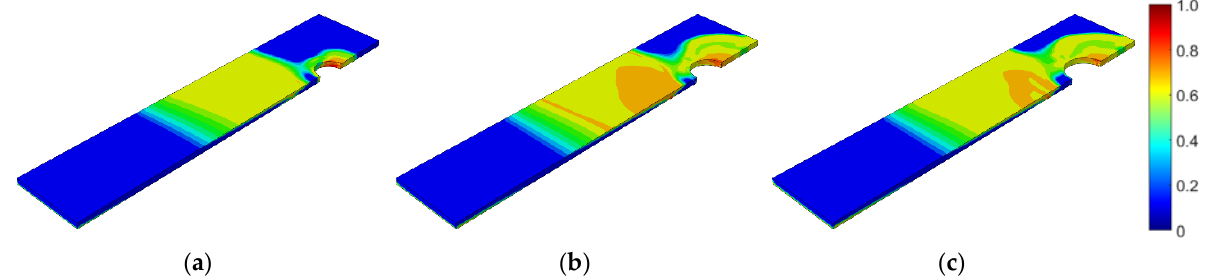
Figure 8. Fatigue distribution of the normalized logarithmic life repeats in the lower plate for the model with a prestressed bolt with a nut diameter of: ( a ) 10 mm; ( b ) 12 mm; ( c ) 14 mm.